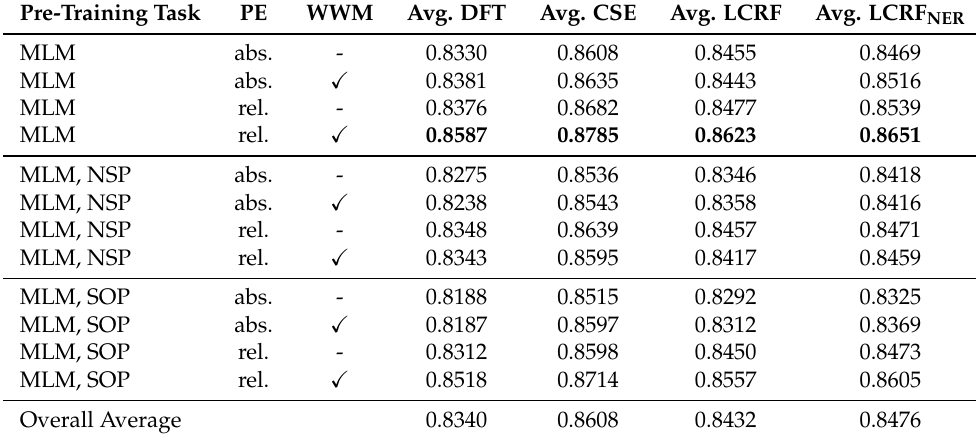
Table 7. Average E- F 1 score of all five NER tasks and three fine-tuning runs. Rows refer to the respective pre-training task, absolute or relative positional encoding (PE), and use of Whole-Word Masking (WWM); Columns refer to the fine-tuning methods Default-Fine-Tuning (DFT), Class-Start- End (CSE), Linear Chain Conditional Random Field (LCRF) and LCRF NER ; best results per column are